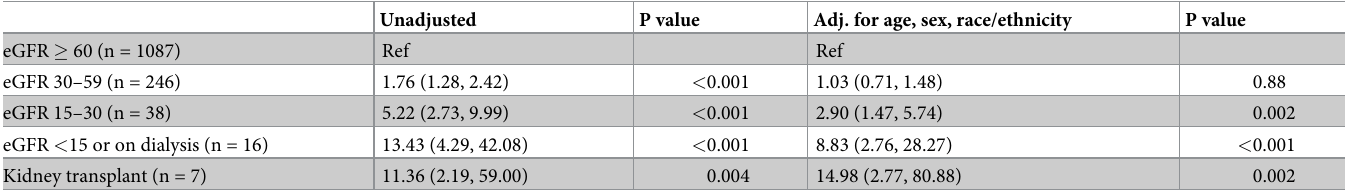
Table 4. Association between CKD phenotypes and COVID-19 associated hospitalization. Unadjusted P value Adj. for age, sex, race/ethnicity P